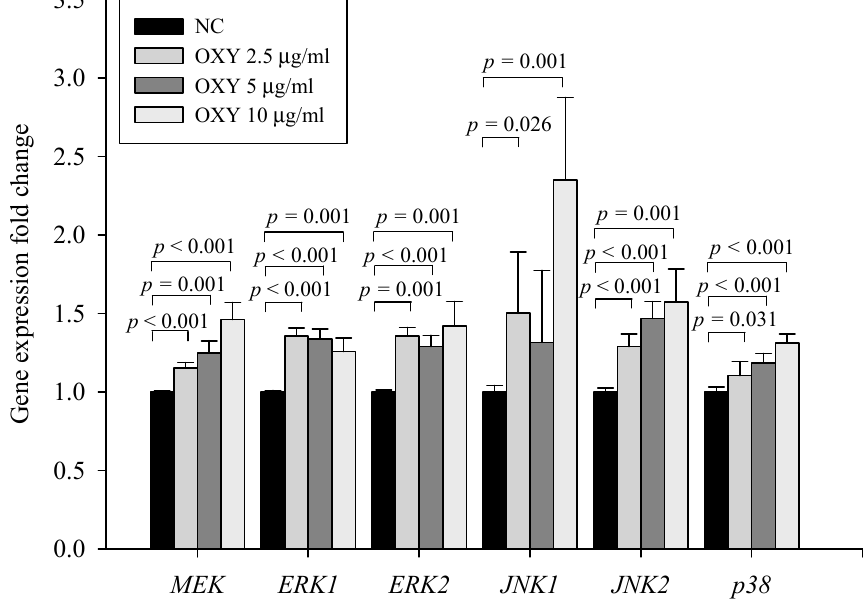
Figure 5. Effect of OXY on expression of MAPK signaling pathway-related genes. mRNA expression levels of MEK , ERK1 , ERK2 , JNK1 , JNK2 , and p38 were determined by qPCR. Each value indicates the mean ± SD of three independent experiments performed in triplicate.